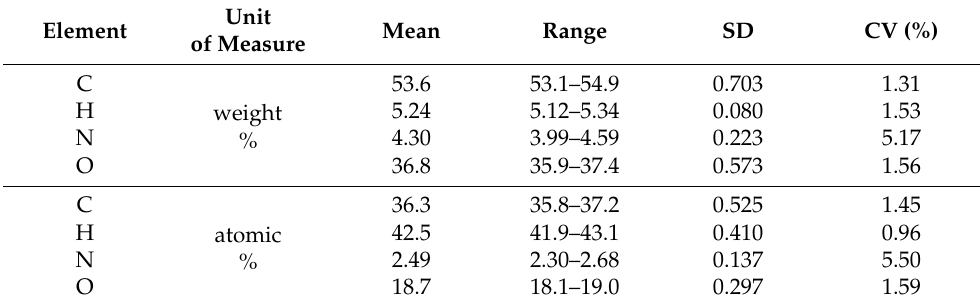
Table 5. Elemental composition of humic acids (HAs) isolated from spent mushroom substrates. Unit Element